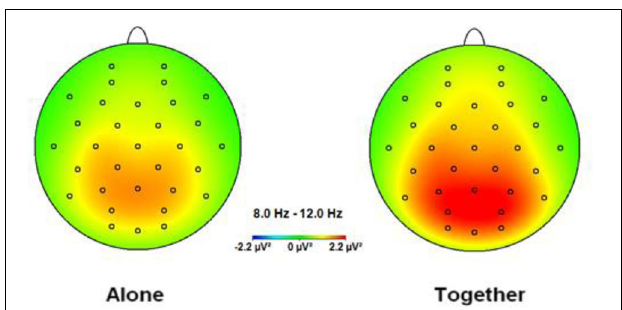
FIGURE 1 | Topographic spectral mapping of absolute EEG alpha power in alone vs. together conditions. The increase in alpha power, marked strongly over the occipital-parietal cortex, is shown from the A to T